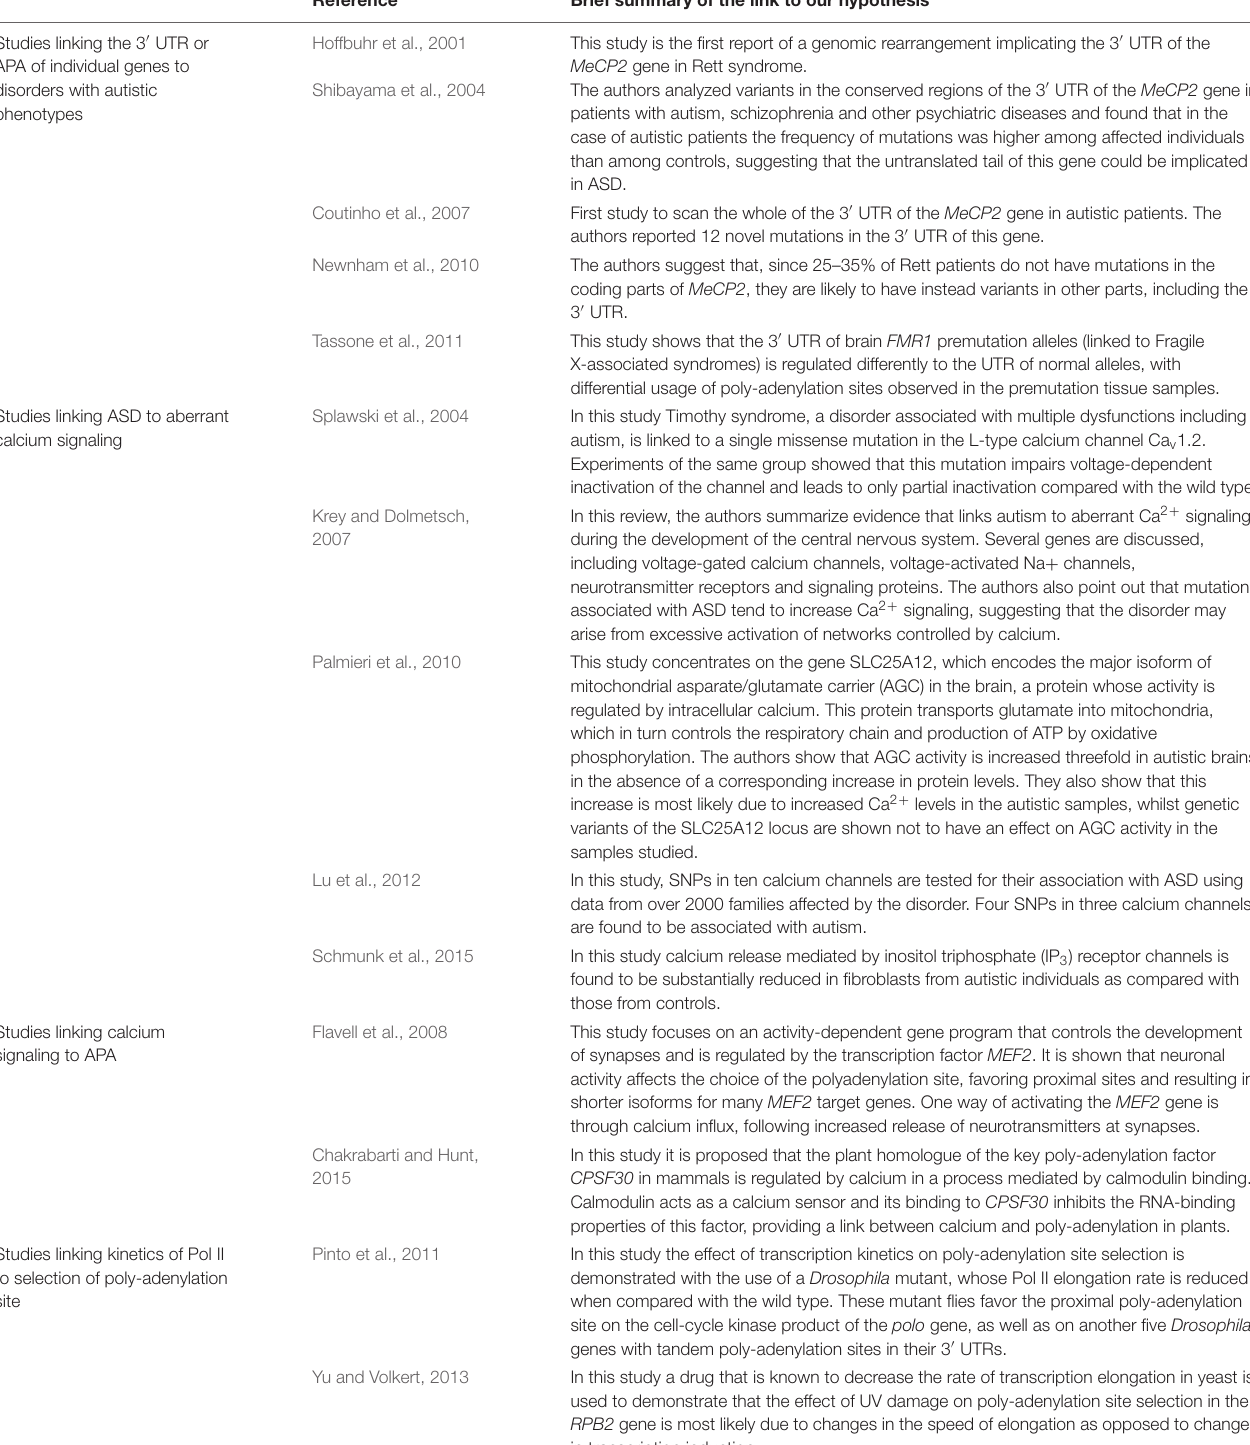
TABLE 1 | Brief summary of selected publications reporting data that support parts of our